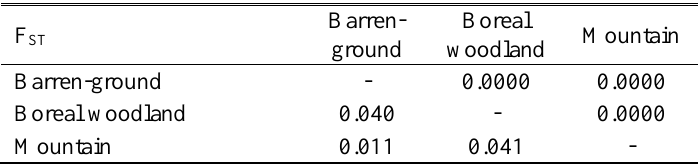
Table A2.2. Pairwise F ST values based on microsatellites for the three major groups identified by structure analysis (below diagonal) and pairwise P values (above diagonal).